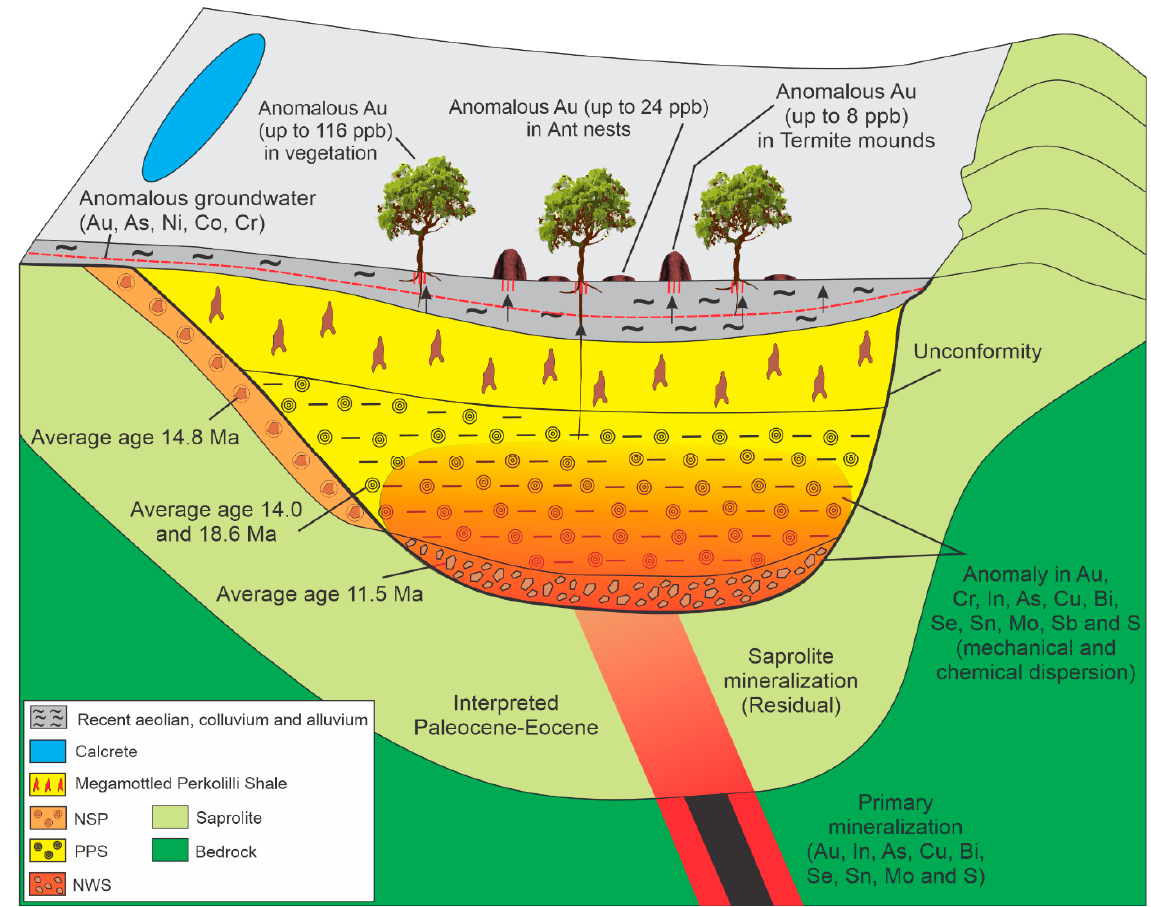
Figure 22. Summary of dating and geochemical dispersion in saprolite, ferruginous materials (NSW, PPS, NSP), groundwater, vegetation and termite mounds. Groundwater, vegetation, termite mounds and ant nests data are derived from Lintern et al. (2013) and Stewart and Anand (2014).